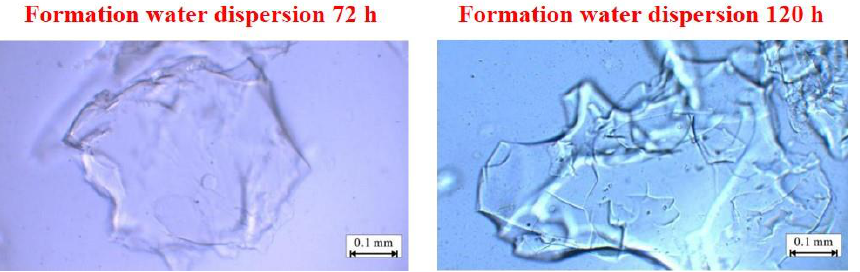
Figure 3. Micrograph of PEG-1 after dispersion.